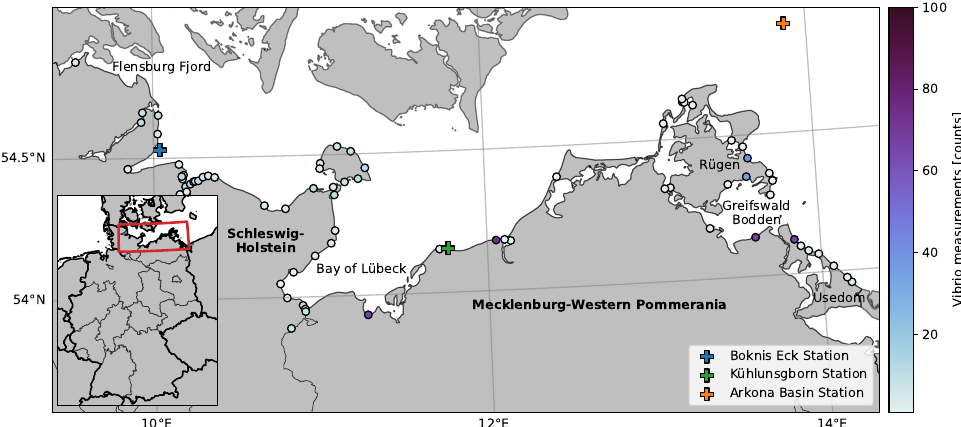
Figure 1. Locations of all Vibrio vulnificus sampling points along the German Baltic coast used in this study. The colour coding of the dots indicates the number of samples available per location between 2008 and 2019. The crosses indicate the positions of the in situ stations at which the hydrodynamic model was validated. Labelled locations are important for results and